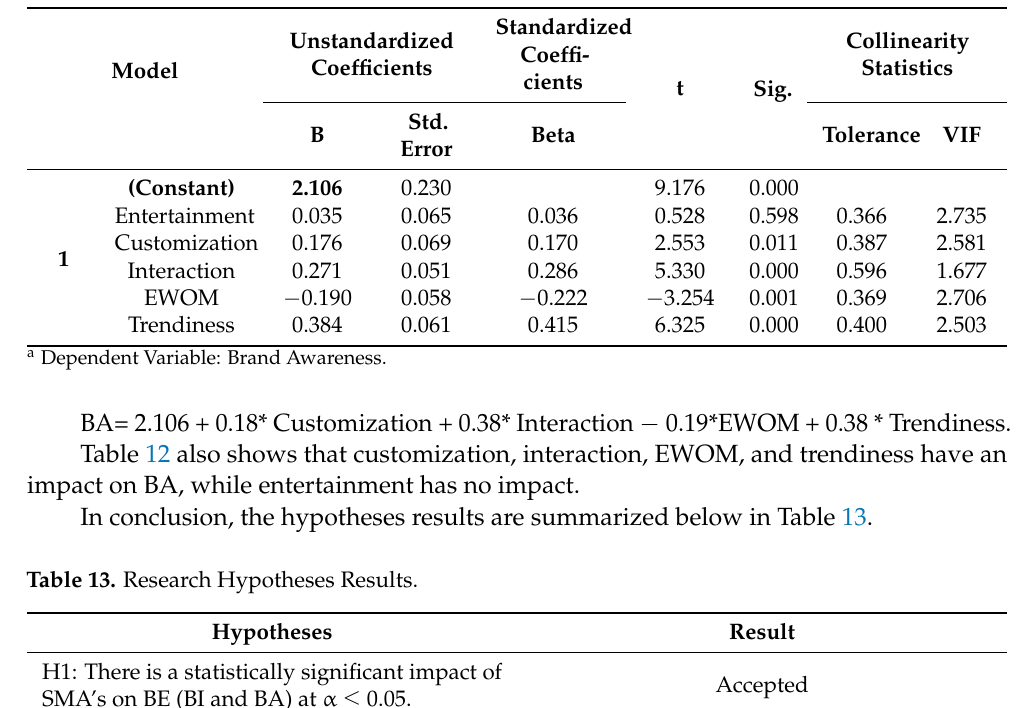
Table 12. Regression 3: Coefficients a .